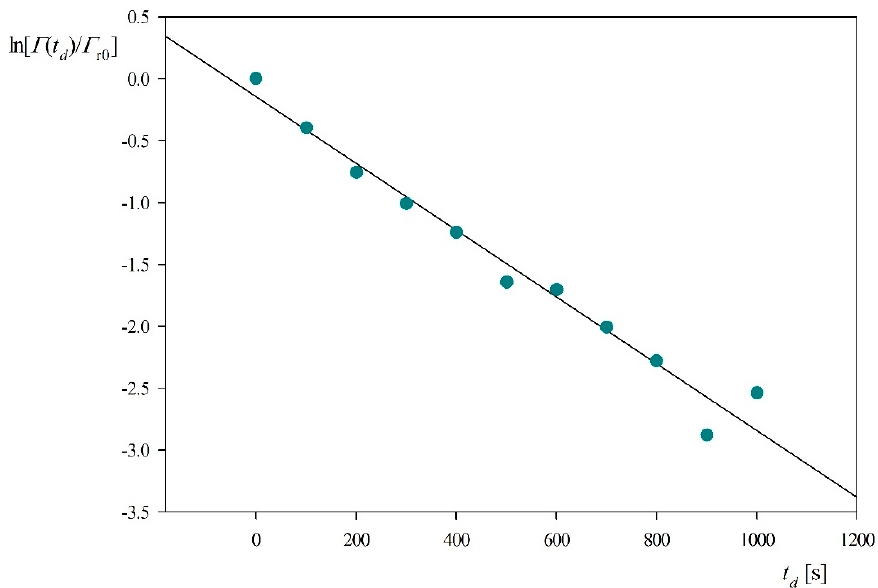
Figure 8. Myoglobin desorption kinetics derived from QCM and expressed as the dependence of ln [ Γ r ( t d ) / Γ r 0 ] on the desorption time t d ; silica sensor pH 3.5, NaCl concentration 0.15 M, flow rate 2.5 × 10 − 3 cm 3 s − 1 .